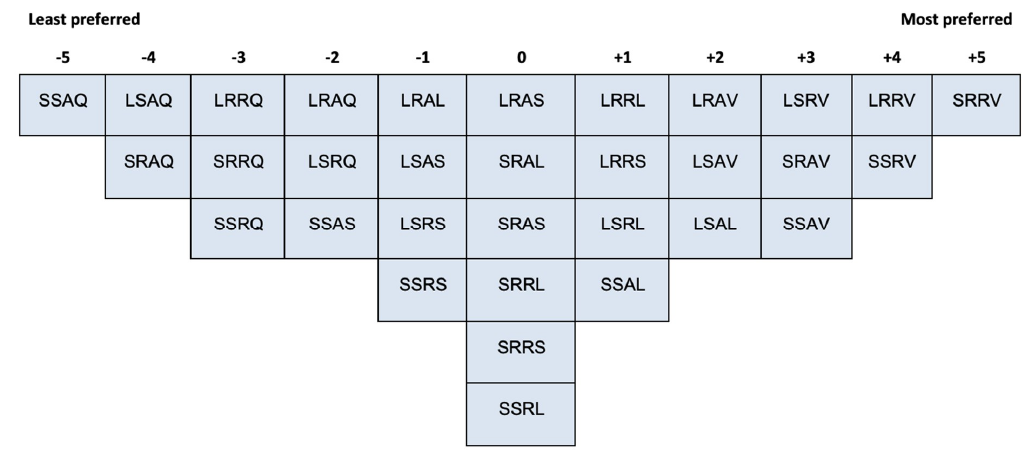
Figure 9. The shared Q-sorting result of participants loaded on Q-factor 3.